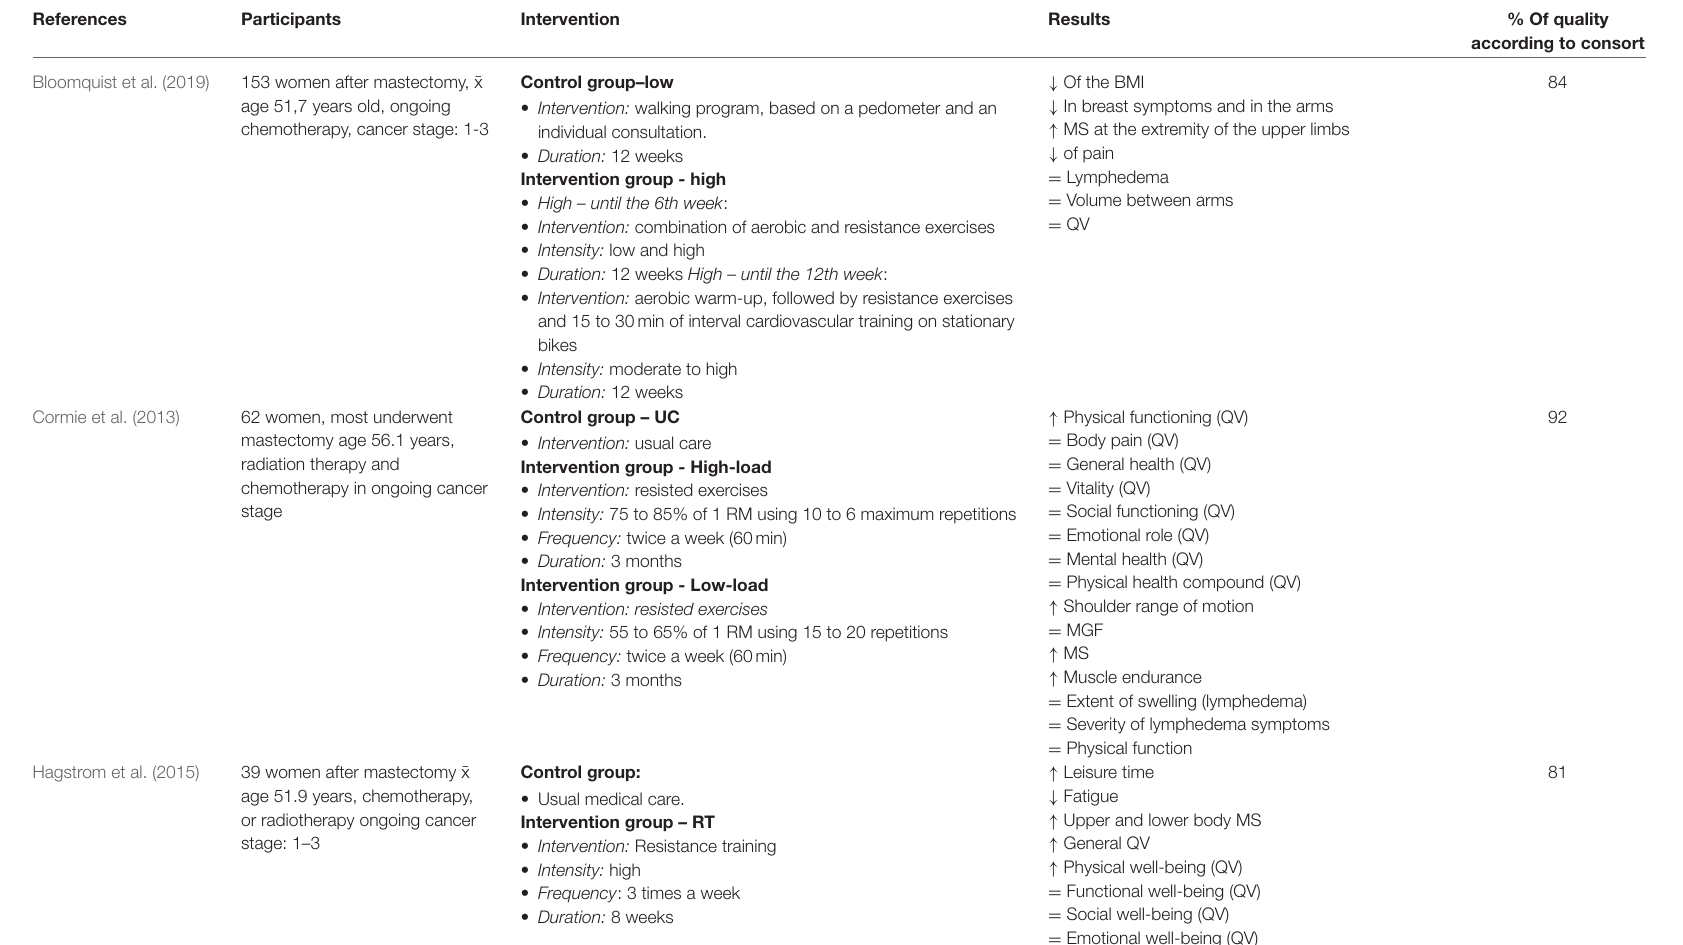
TABLE 1 | Main characteristics of the studies included in this